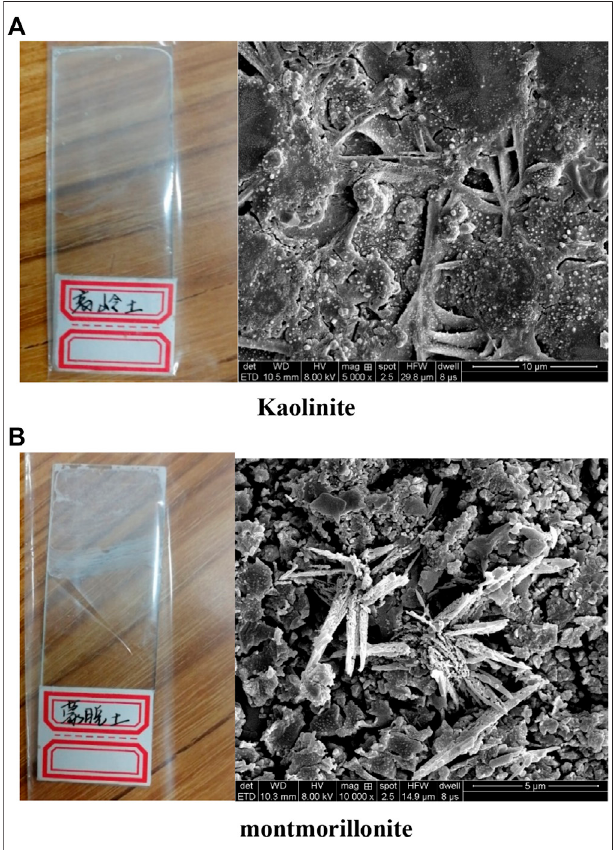
FIGURE 1 | Clay coated glass slide and SEM